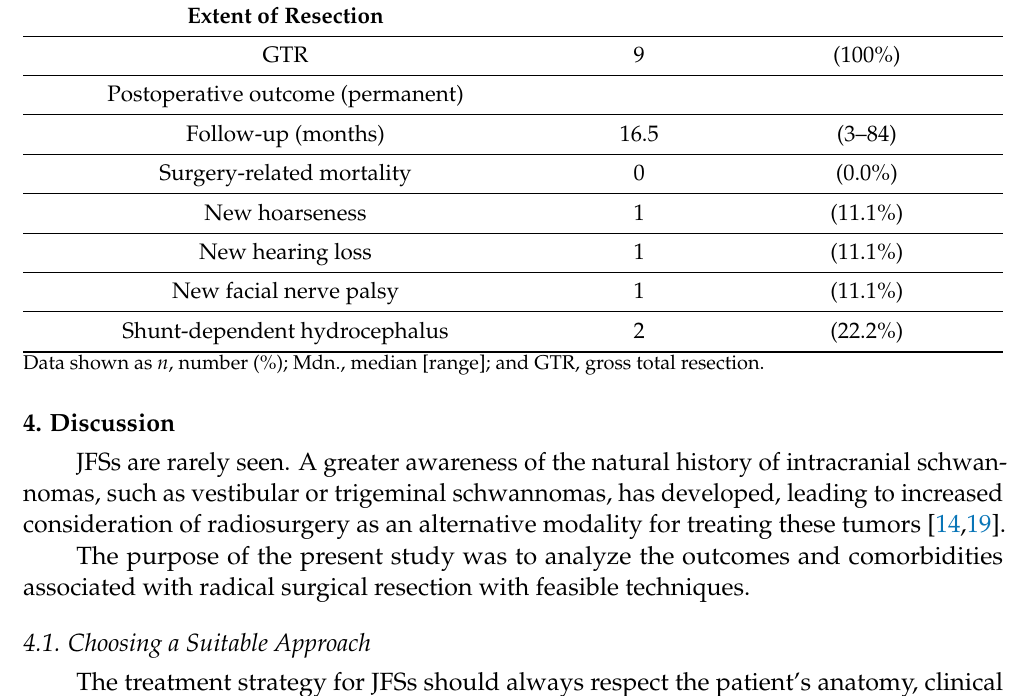
Table 3. Postoperative